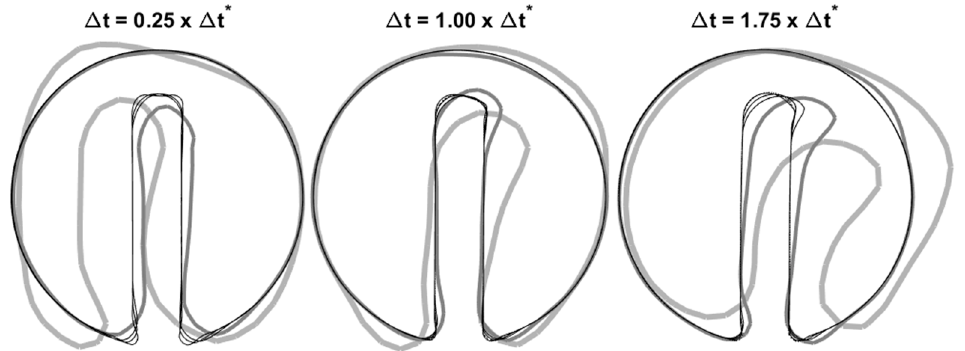
Figure 9. The reconstructed notched cylinder after one revolution for different time increments ( ∆ t = 0.25 ∆ t ∗ ,1.00t ∗ and 1.75 ∆ t ∗ ) and mesh spacing: N 1 × N 2 = 50 × 50 (light-grey), N 1 × N 2 = 100 × 100 (dark-grey), N 1 × N 2 = 200 × 200 (dashed), N 1 × N 2 = 300 × 300 (dash-dotted), N 1 × N 2 = 400 × 400 (dotted), N 1 × N 2 = 500 × 500 (solid line).